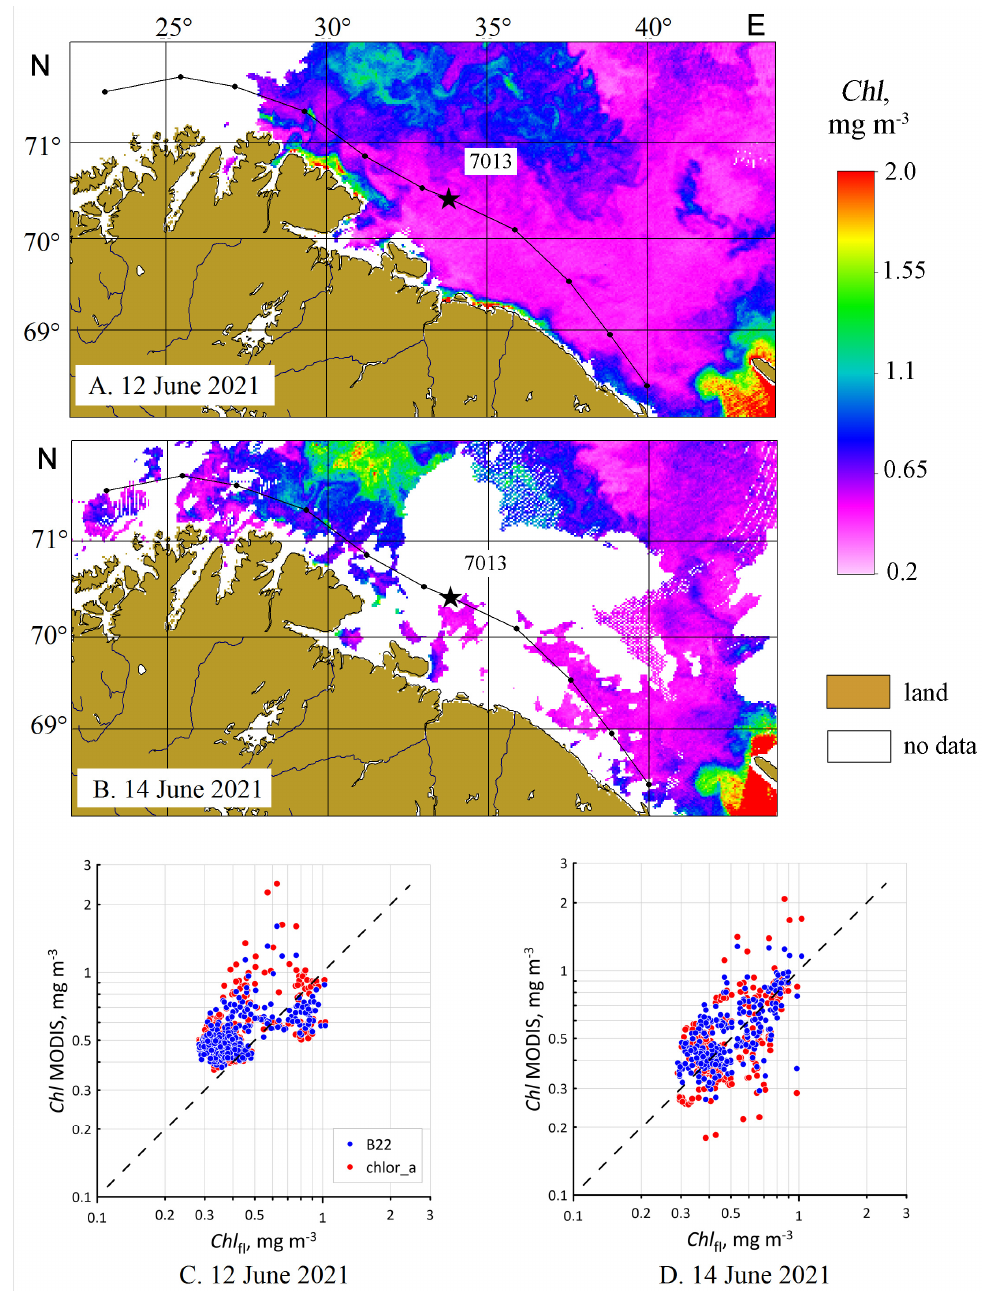
Figure 3. The spatial distributions of Chl concentration according to MODIS/Aqua data on 12 June ( A ) and 14 June ( B ), 2021, calculated using the B22 regional algorithm. The black line shows the ship’s route. Comparison of the Chl values calculated from satellite data on 12 June ( C ) and 14 June ( D ), 2021 and measured with a fluorimeter. The dotted line is the perfect fit (1:1).